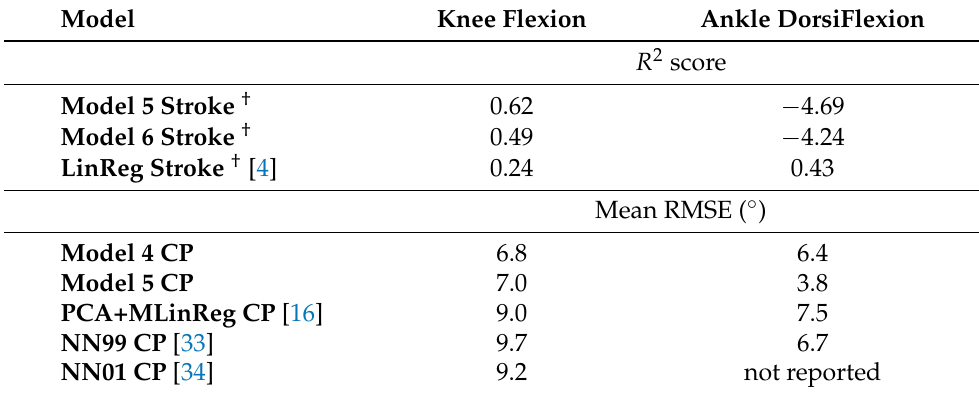
Table 7. Performance comparison of the prediction methods. LinReg and MLinReg correspond to linear regression and multiple LinReg, respectively, in [4,16]. PCA stands for principal component analysis. NN99 and NN01 correspond to feedforward neural networks, respectively, in [33,34].